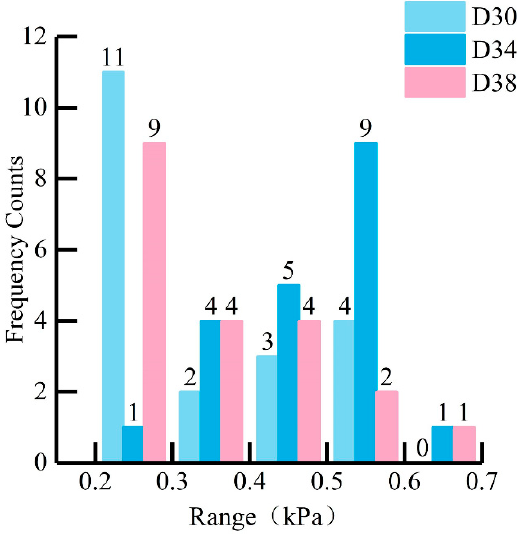
Figure 16. Frequency distribution of minimum negative pressure.